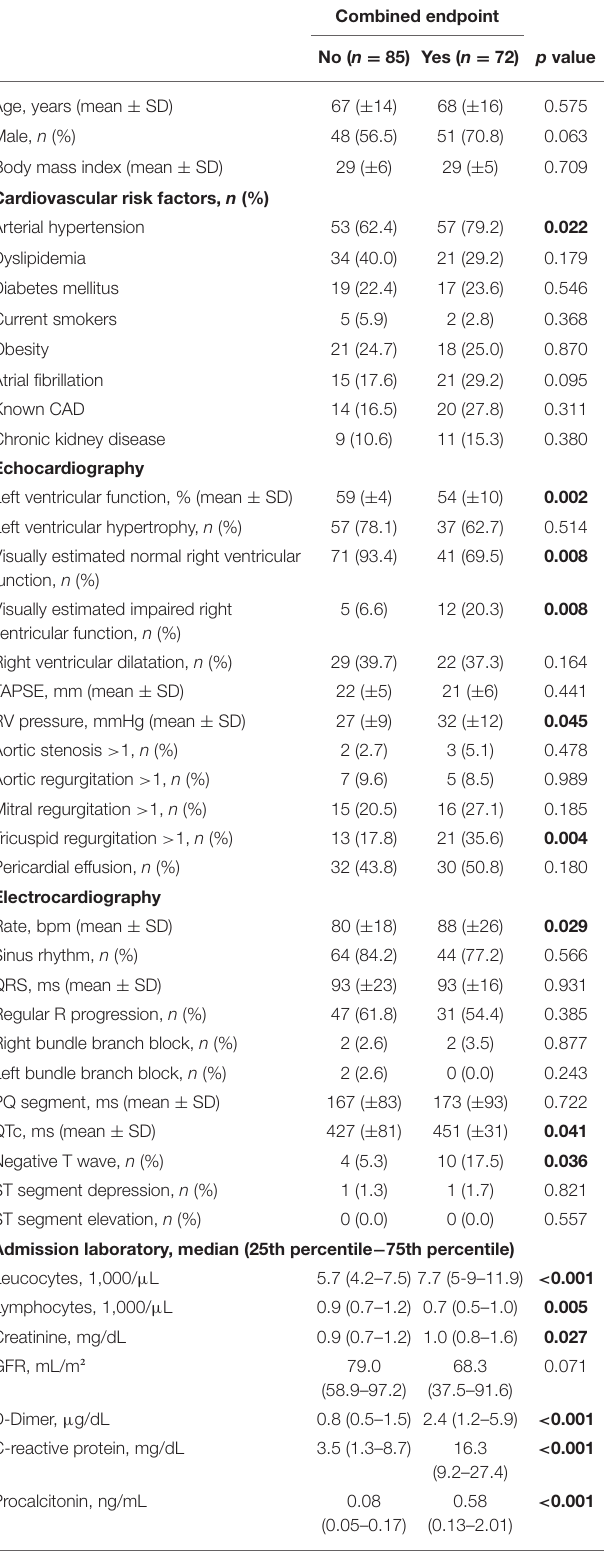
TABLE 2 | Baseline characteristics stratified according to the combined